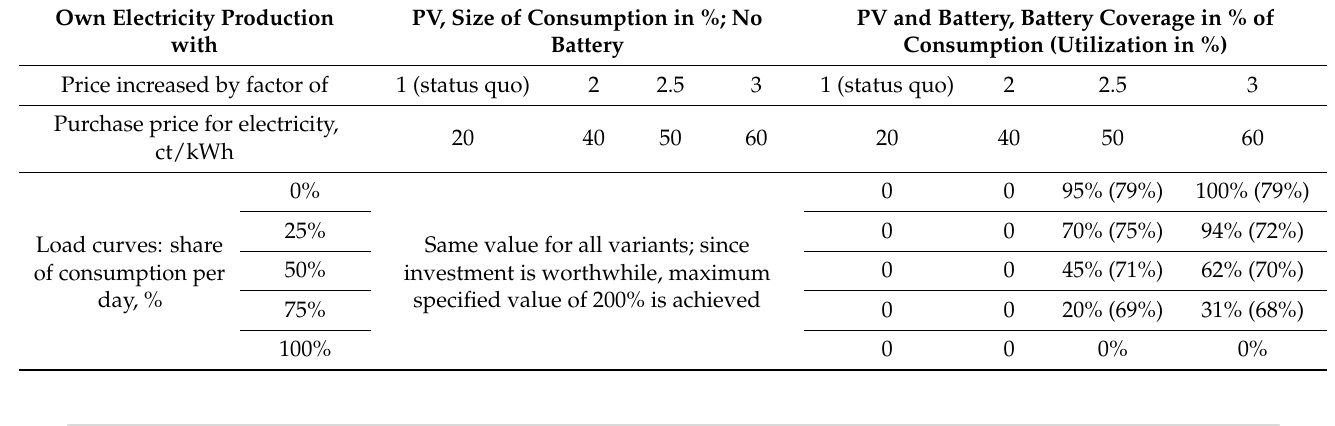
Table 6. Power generation technology: size of PV system and battery, and battery utilization, in %, when limited to a maximum of 200% of farm consumption.